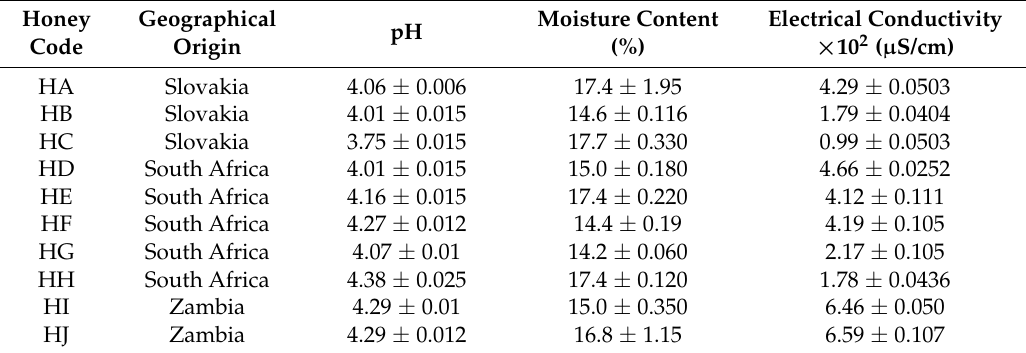
Table 2. Electrical conductivity ( µ S/cm), moisture content (%), and pH of honeys